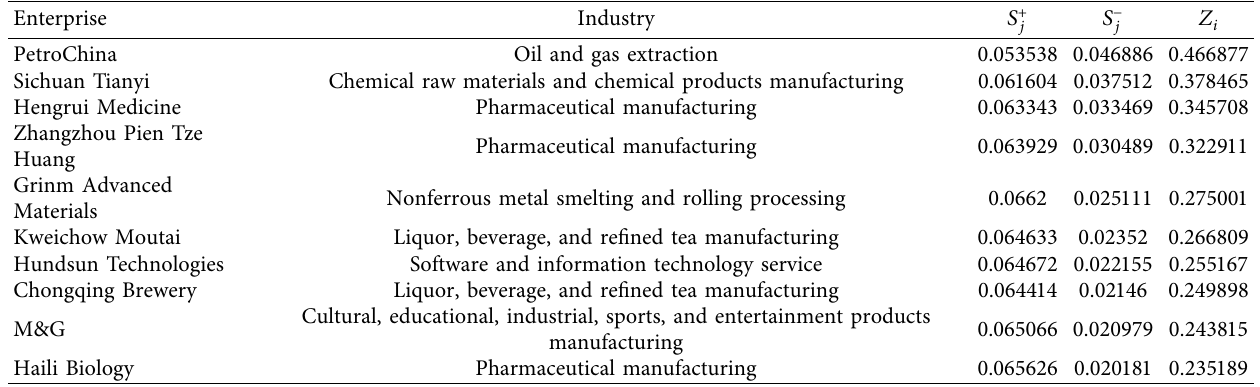
Table 3: Top-10 enterprises in terms of